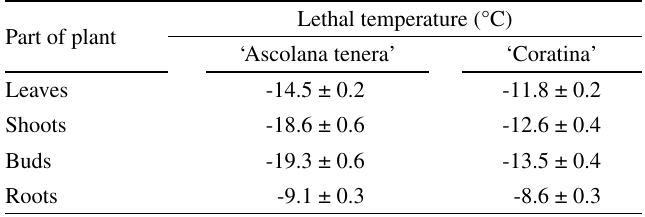
Table 1 - Lethal temperature (°C) as evaluated by differential thermal analysis for various organs in two acclimatized olive cultivars having different resistance to cold: ‘Ascolana tenera’, very re- sistant; ‘Coratina’, poorly